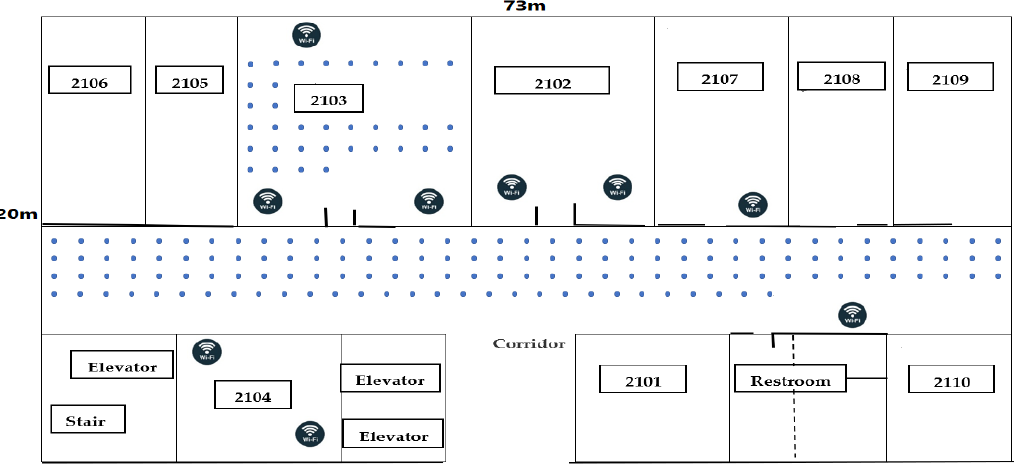
Figure 4. Experimental layout conducted in UESTC for generating dataset B.